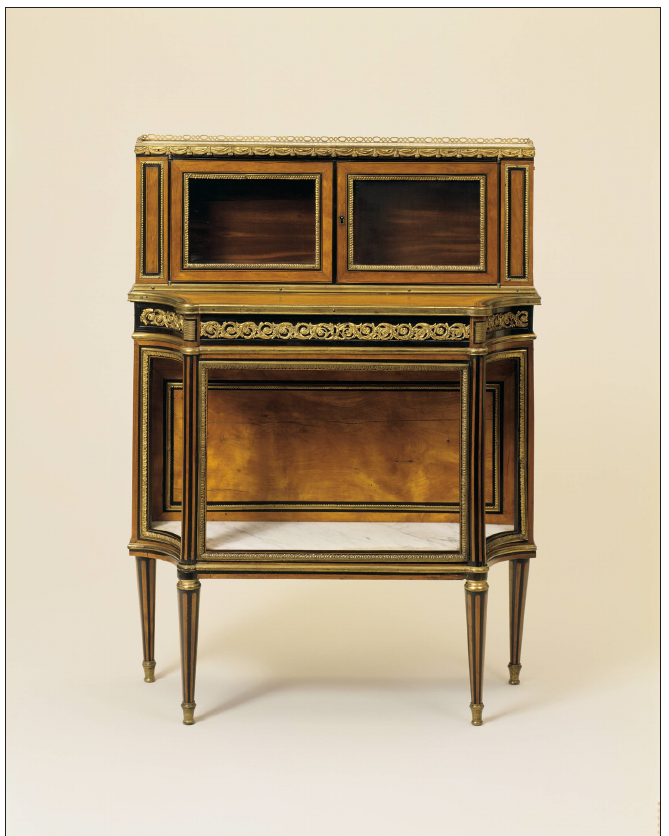
Fig. 5 : Ladies’ writing table ( Bonheur-du-Jour ), Paris, c. 1785, mahogany, teakwood, gilt bronze, marble, Hillwood Estate, Museum, and Gardens, Washington DC (inv.